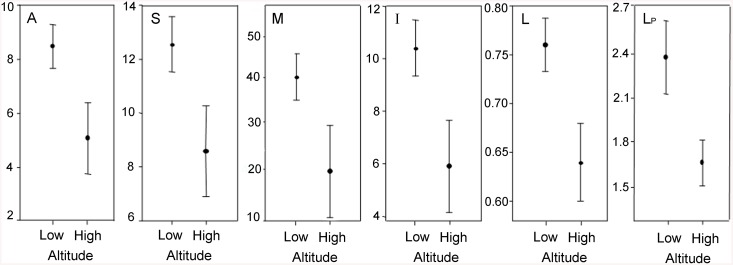
Effects of altitude on properties of plant—flower-visitor networks in a cloud forest in Antioquia, Colombia.Data are presented as mean ± standard errors for network properties at low and high altitude. A (Welch t—test = 3.05, P = 0.004), S (Welch t—test = 2.61, P = 0.013), M (Welch t—test = 2.52, P = 0.016), I (Welch t test = -.2.99, P = 0.005), L (t—test = -2.31, P = 0.026), L
P (t—test = 2.14, P = 0.038).